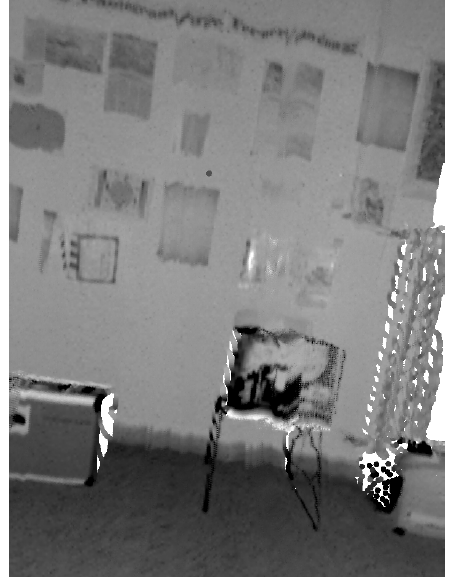
Figure 5. Intensity